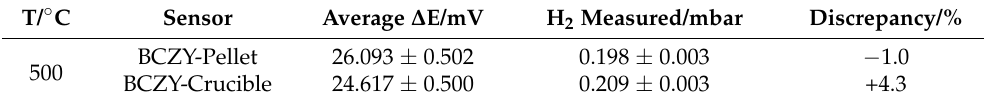
Table 3. Accuracy of the sensors was evaluated with 0.2 mbar hydrogen sample at 500 ◦ C. T/ ◦ C